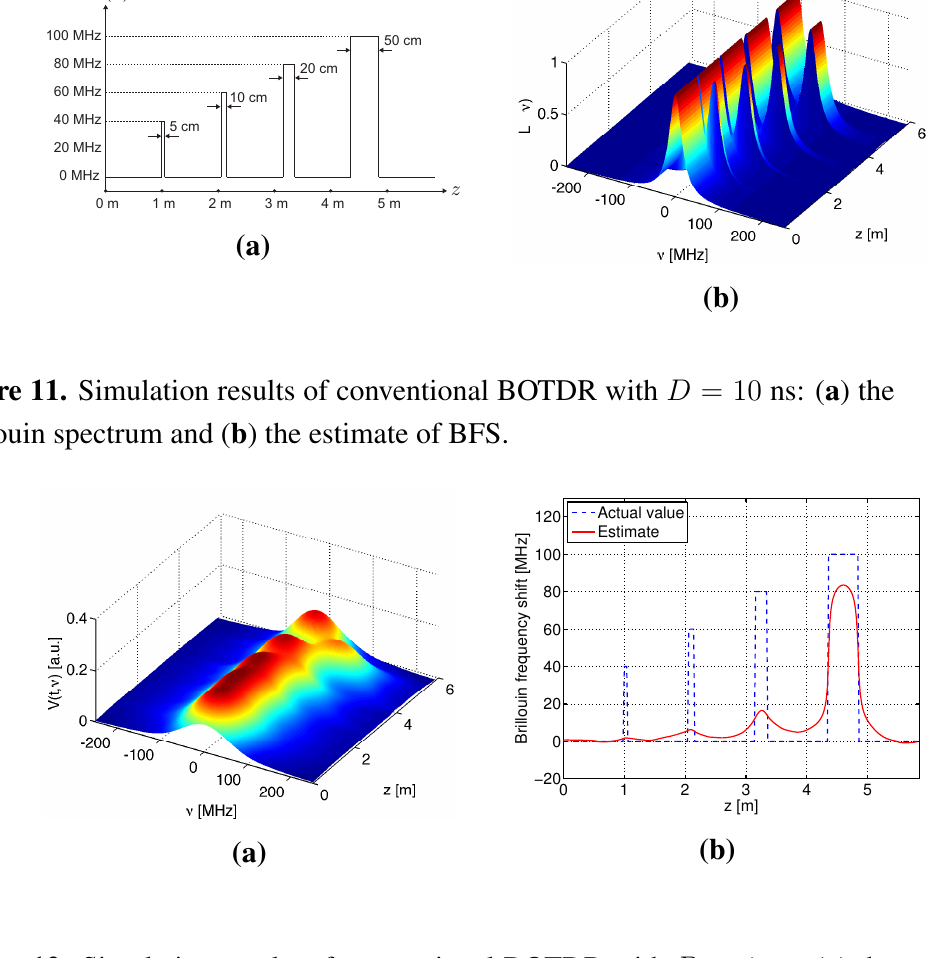
Figure 12. Simulation results of conventional BOTDR with D = 1 ns: ( a ) the Brillouin spectrum and ( b ) the estimate of